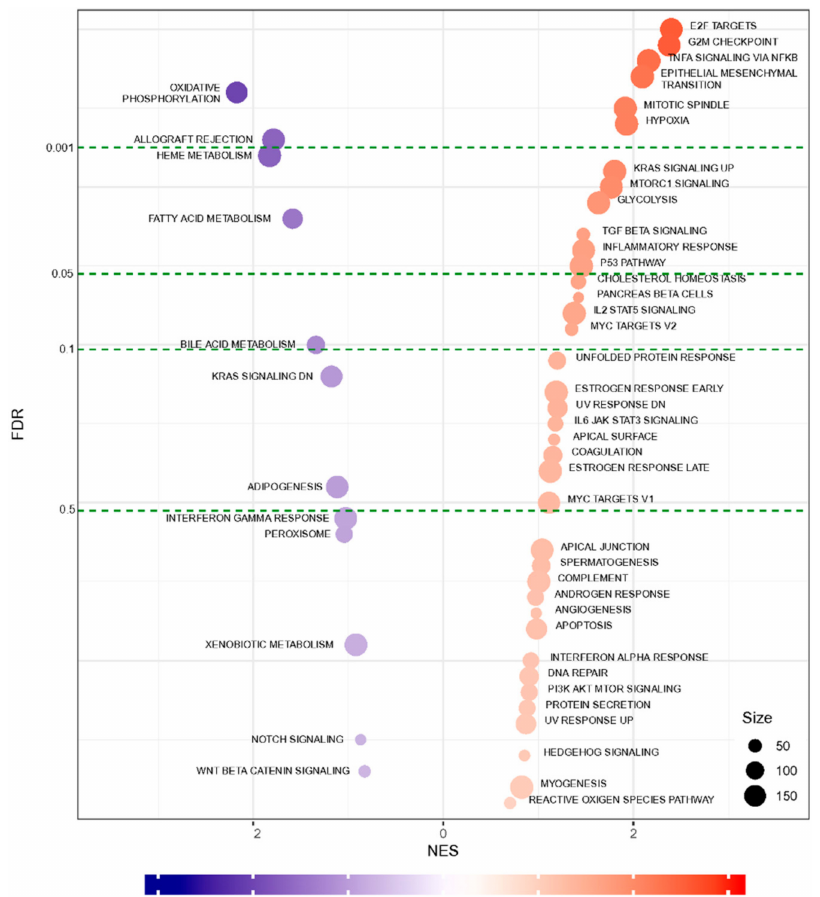
Figure 4. GSEA of whole transcriptome comparisons. A bubble chart of the GSEA hallmark indicates the normalized enrichment scores (NES, x -axis) and false discovery rate (FDR, y -axis). The size of each circle represents the weighted numbers of genes involved in the term.